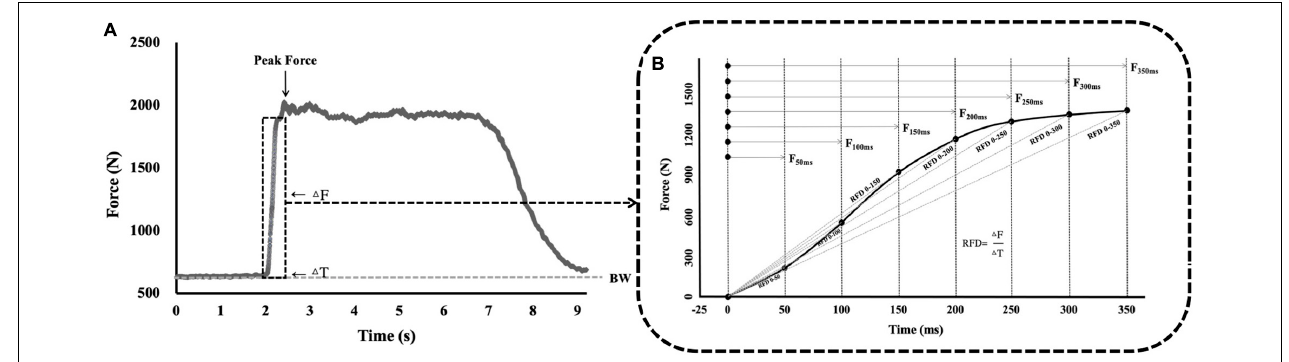
FIGURE 3 | Commonly quantified variables during the analysis of the IMTP force-time curve. (A) The IMTP force-time curve at 0–9 s. (B) The IMTP force-time curve at 0–350 ms. BW, basic weight; (cid:49) F , change in force; (cid:49) T , change in time; PF, peak force; F 50 , force at 50 ms; F 100 , force at 100 ms; F 150 , force at 150 ms; F 200 , force at 200 ms; F 250 , force at 250 ms; F 300 , force at 300 ms; F 350 , force at 350 ms; RFD, rate of force development; RFD 0 − 50 , RFD at 0–50 ms; RFD 0 − 100 , RFD at 0–100 ms; RFD 0 − 150 , RFD at 0–150 ms; RFD 0 − 200 , RFD at 0–200 ms; RFD 0 − 250 , RFD at 0–250 ms; RFD 0 − 300 , RFD at 0–300 ms; RFD 0 − 350 , RFD at 0–350 ms; IMTP, isometric mid-thigh pull; RFD, rate of force development.